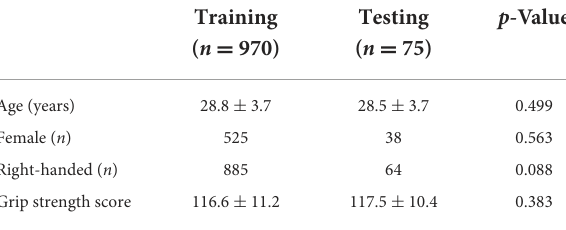
TABLE 1 Summary of training and testing